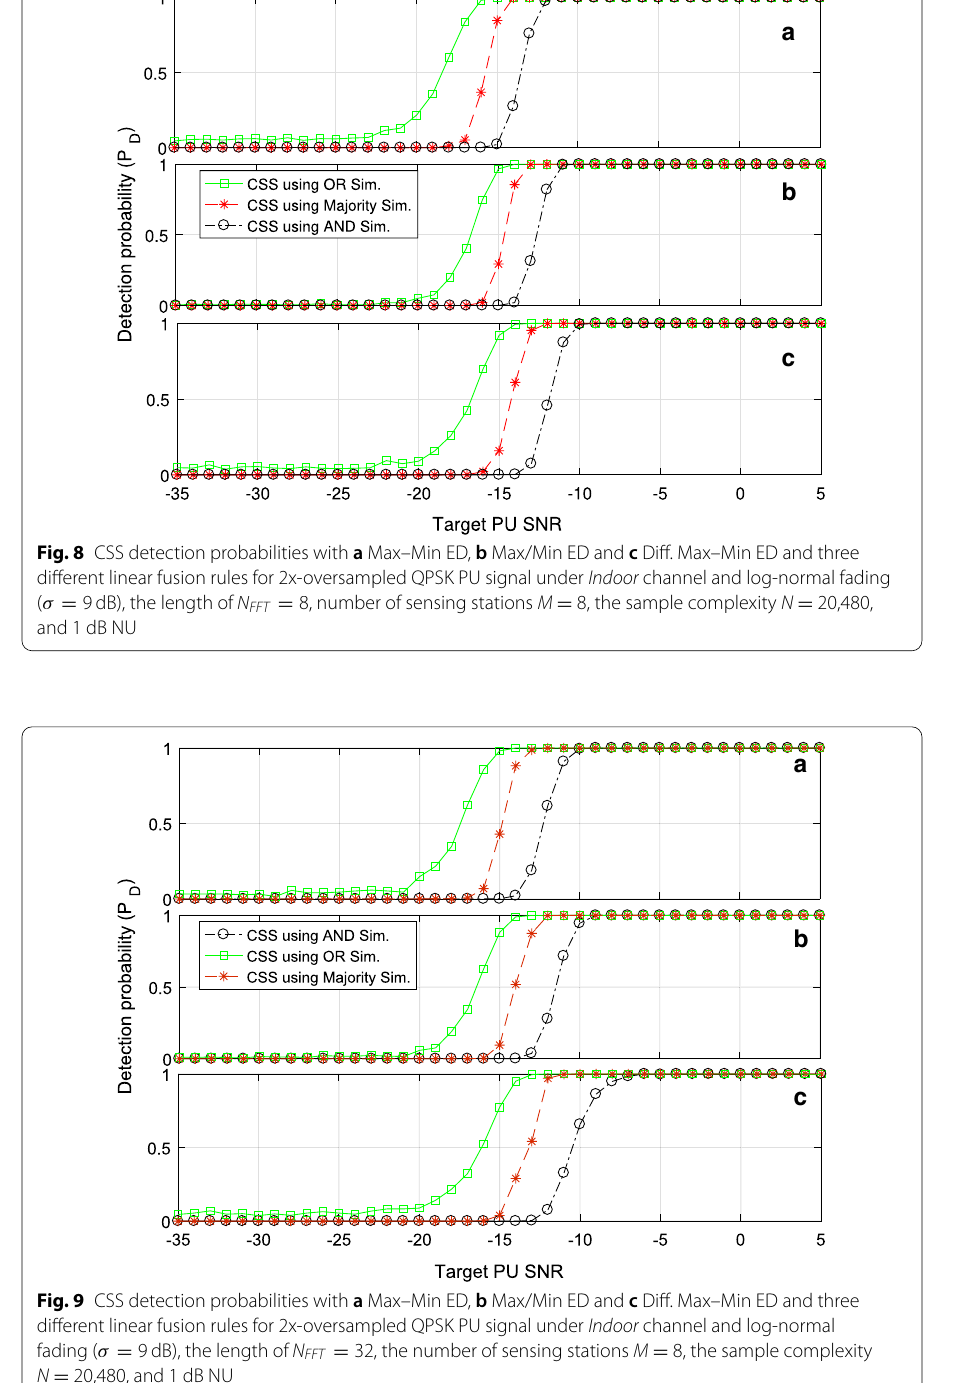
8, the sample complexity =